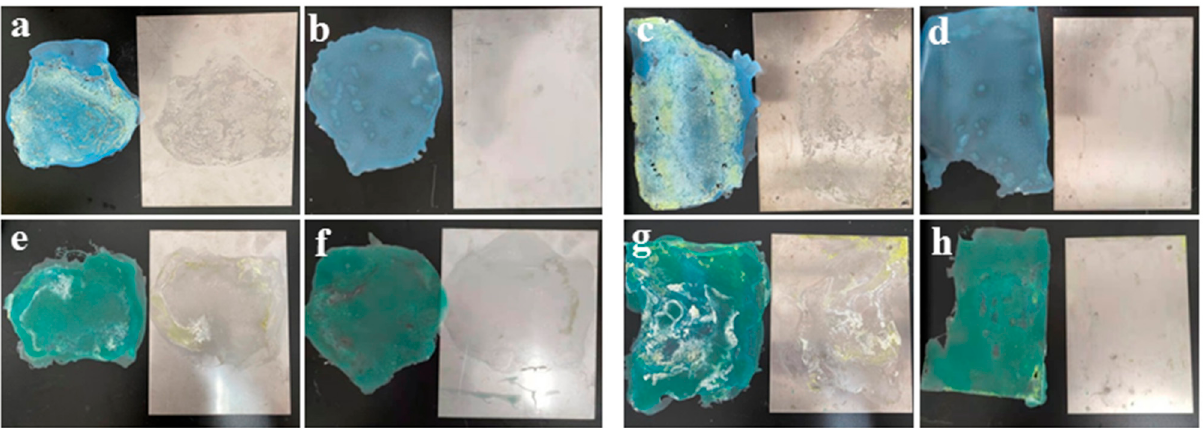
Figure 6. High decontamination effectiveness of polymeric coatings C1 and DeconGel 11001 with high surface contamination levels.